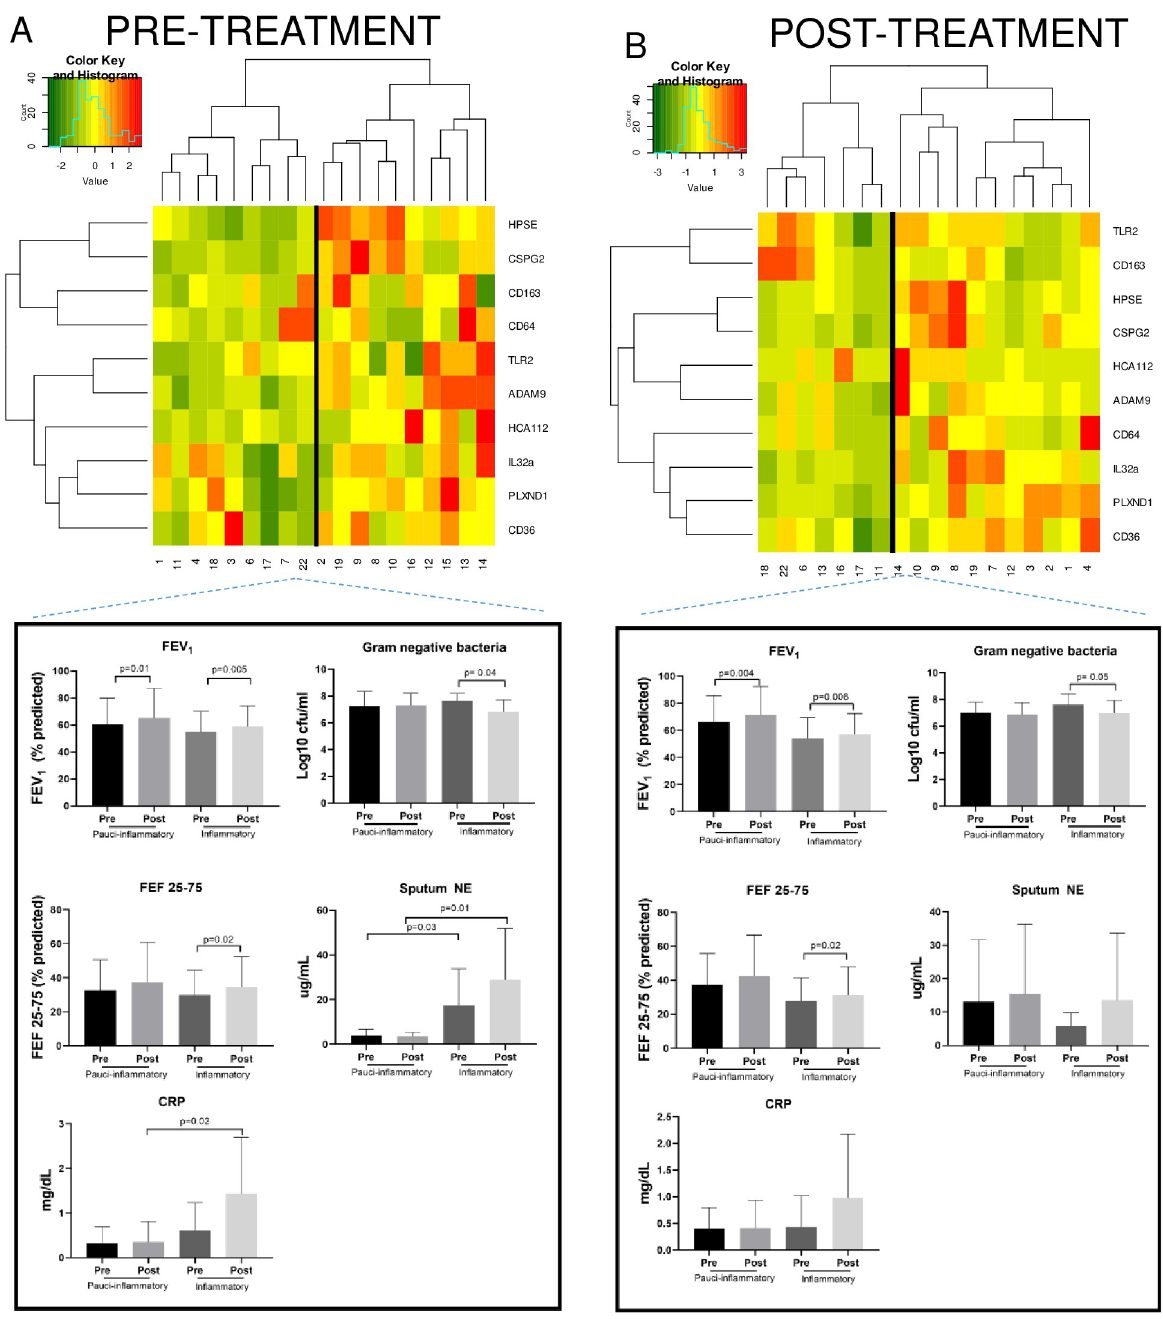
Fig 5. Dendrogram, heat map, and clinical characteristics for hierarchical clustering based on panel expression pre and post treatment. (A) The pre-treatment dendrogram only includes gene expression values prior to AZLI treatment and (B) the post-treatment dendrogram only includes gene expression values following AZLI treatment. Each column represents an individual patient and each row represents a single gene. For each dendrogram, subject IDs are depicted below each column, so that changes from pre- to post-treatment endpoints for each subject can be visualized. Expression of genes for each subject is depicted with a color-coded histogram representing level of gene expression on a natural log scale. Green signifies reduced gene expression; red indicates increased expression. Clusters are labeled “Pauci-inflammatory” or “Inflammatory” based on the degree of gene expression for pre and post-AZLI time points. The clinical characteristics of subjects in each cluster before and after inhaled AZLI are represented in the figures below each dendrogram to include ppFEV 1 , ppFEF 25-75 , gram negative bacterial density (log 10 CFU/ mL), sputum neutrophil elastase ( μ g/mL), each of which are evaluated by two sample t-tests. Bars represent mean values and error bars represent SDs on the same scale as means.